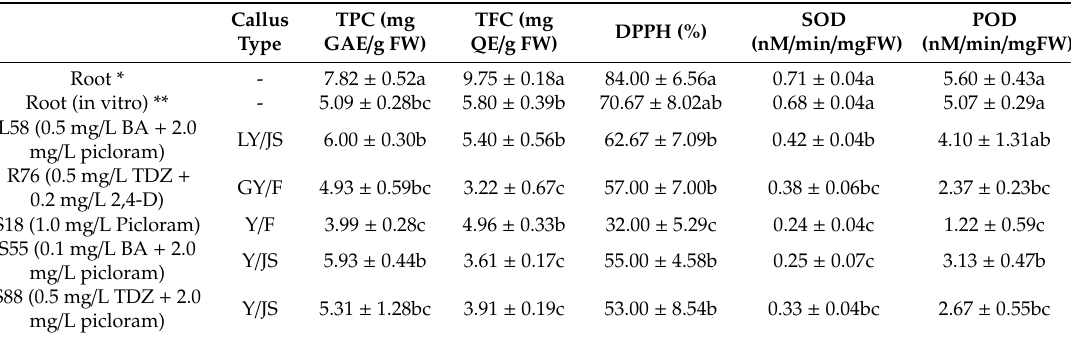
Table 1. Quantitative analysis of TPC, TFC, DPPH, SOD, and POD in Sophora flavescens callus and explant (n = 3 biological replicates).